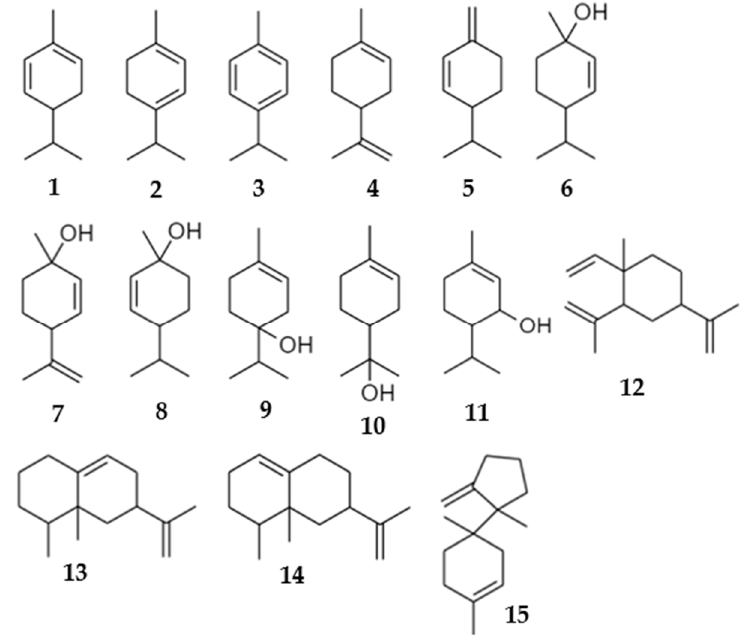
Figure 1. Structure of compounds presented in Table 1.